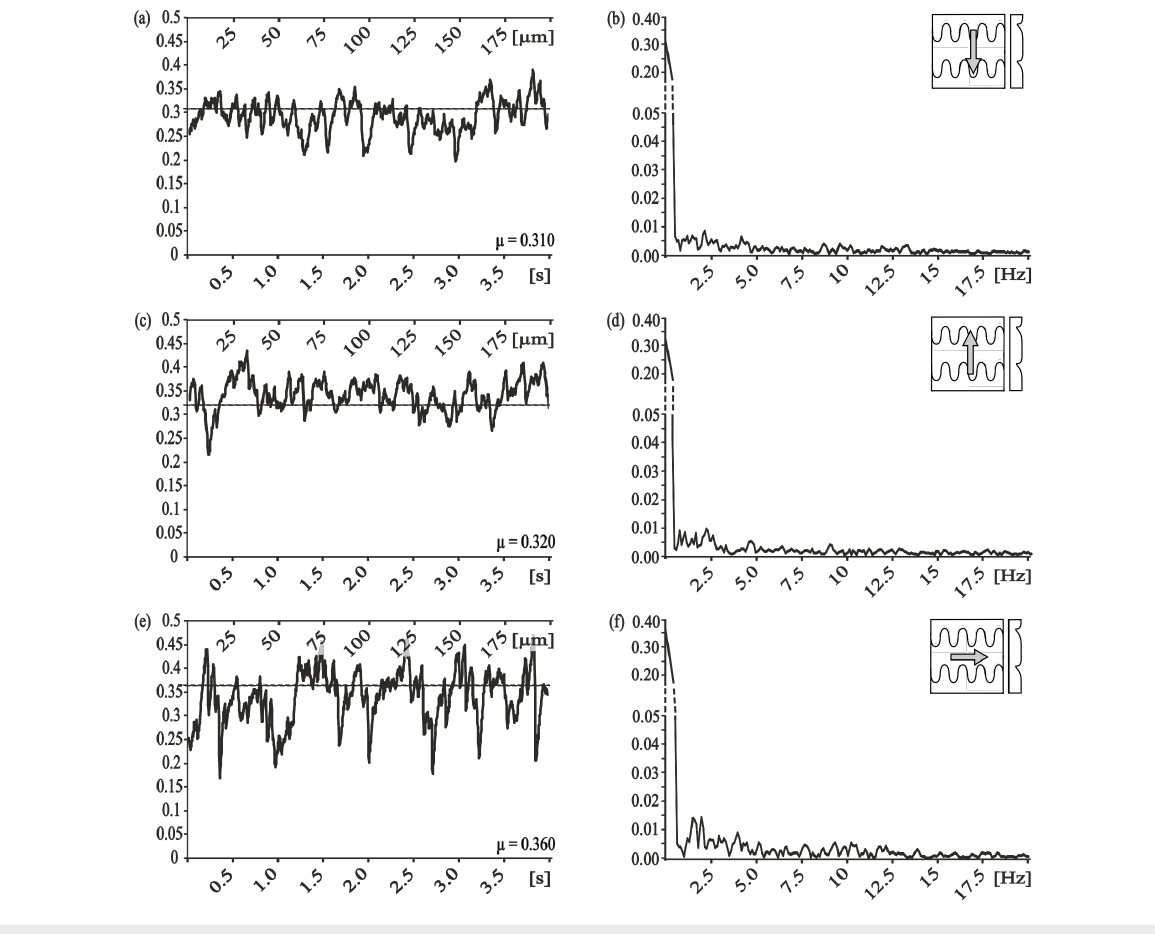
maximal amplitudes between 0.010–0.025, not minimal stick- slip amplitudes (maximal amplitude: <0.010), as